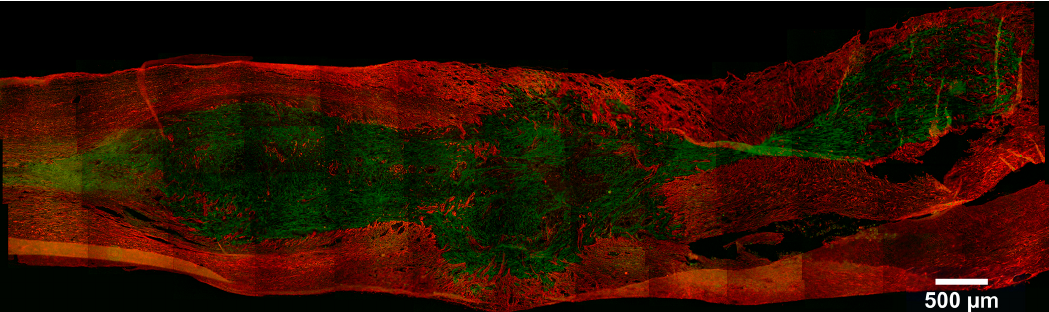
Figure 2. Survival and distribution of green fluorescence protein (GFP)-labeled human MSCs ( green ) in a neuron-specific class III β -tubulin (TUJ1)-labeled ( red ) longitudinal section one month after transplantation in a severe SCI rat model. Scale bar = 500 μ m.